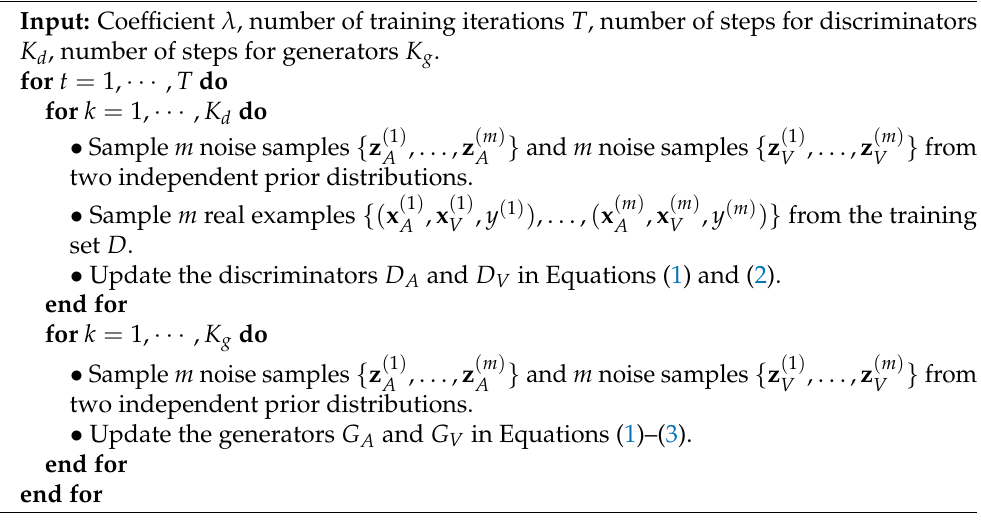
Algorithm 1 Update the parameters of our multimodal conditional